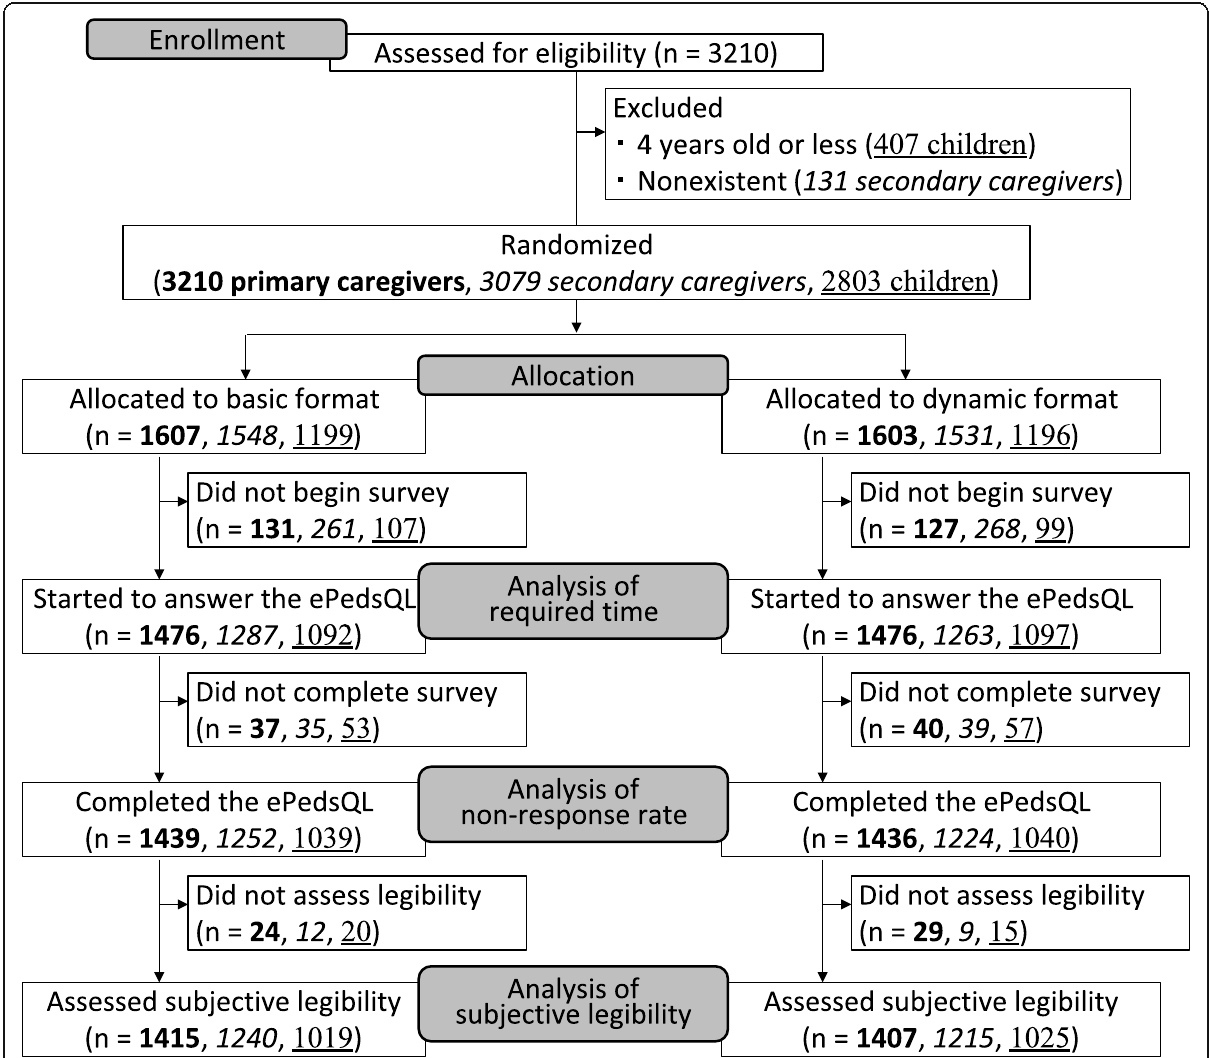
Fig. 2 Flow of participants: Primary caregivers, secondary caregivers and children. Bold, italic, and underlined numbers are the number of primary caregivers, secondary caregivers, and children,